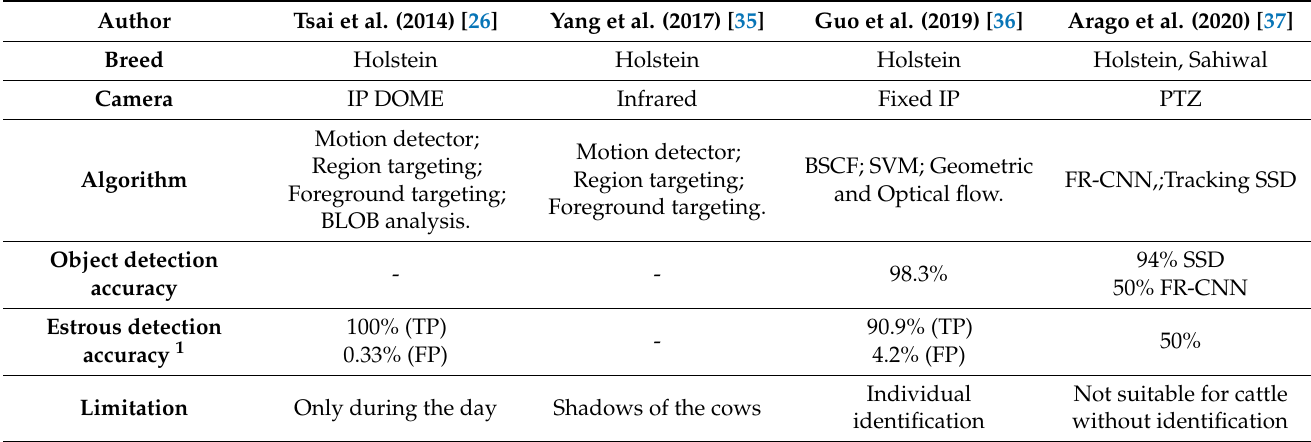
Table 2. Results of detection of estrous cows through video recording and computer vision